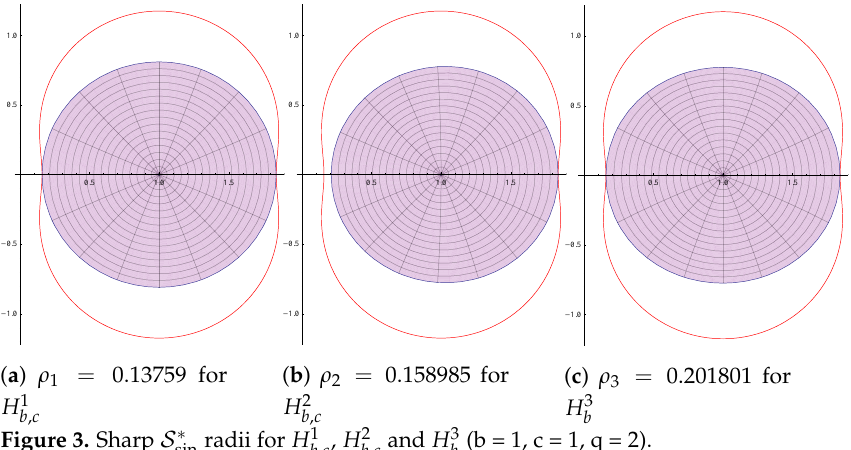
Figure 3. Sharp S ∗